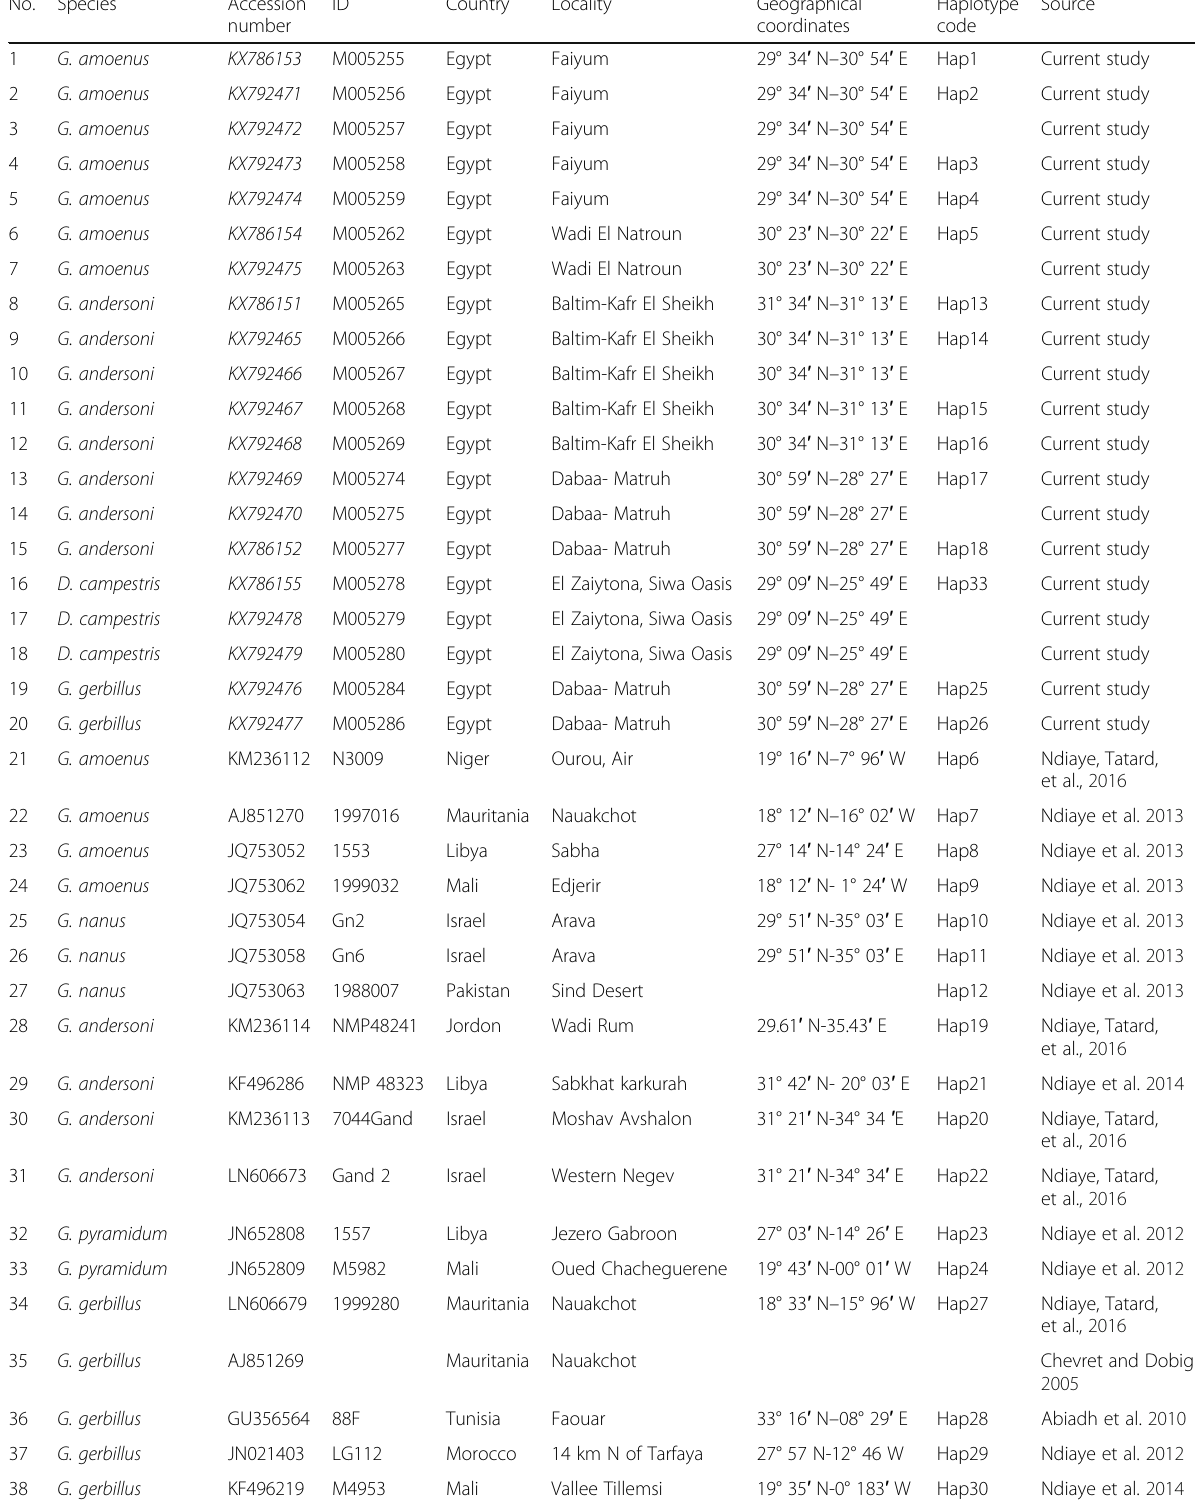
Table 1 List of specimens with their GenBank accession numbers of the sequences of cyt b (italicized numbers refer to original sequences in this study), geographic origin, haplotype code, and literature